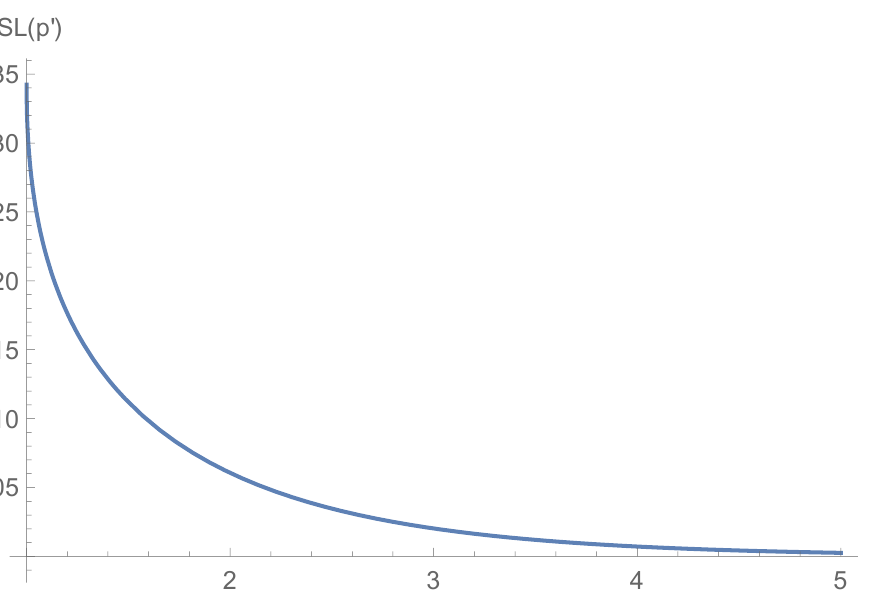
Figure 22. Probability density function for a free superluminal Lorentzian particle as a function of p (cid:48) for | λ | =